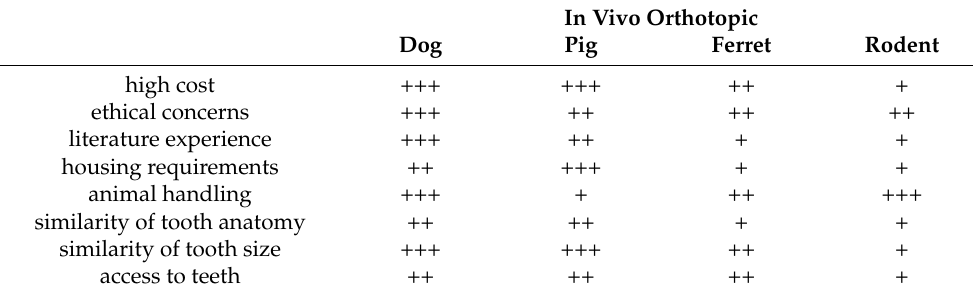
Table 3. Strengths and weaknesses of in vivo orthotopic